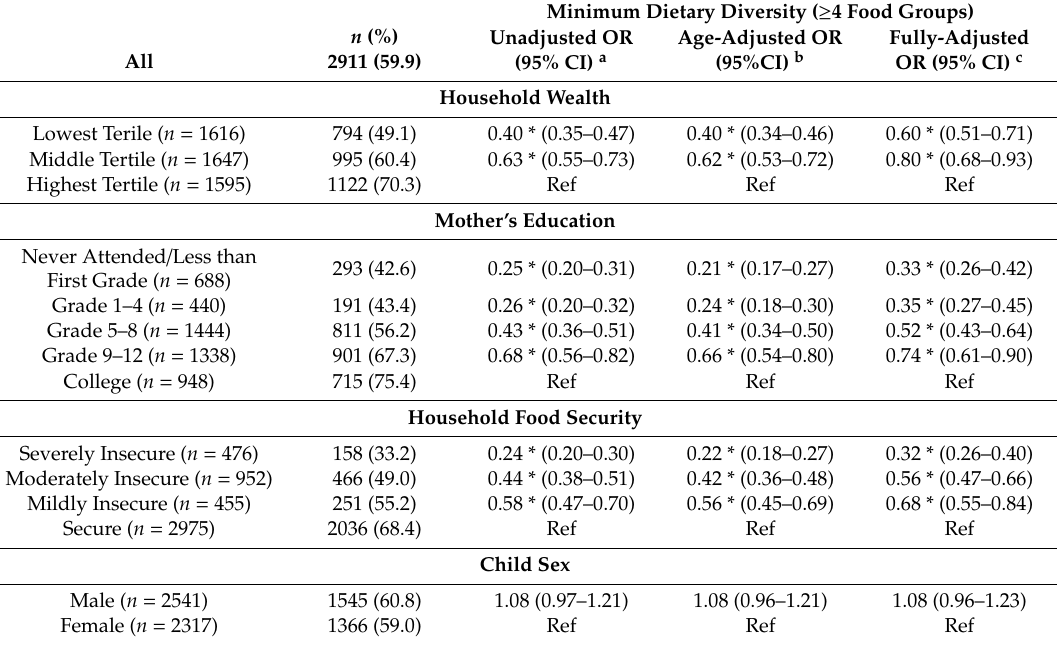
Table 4. Child diet and its association with socio-economic resources in Addis Ababa,